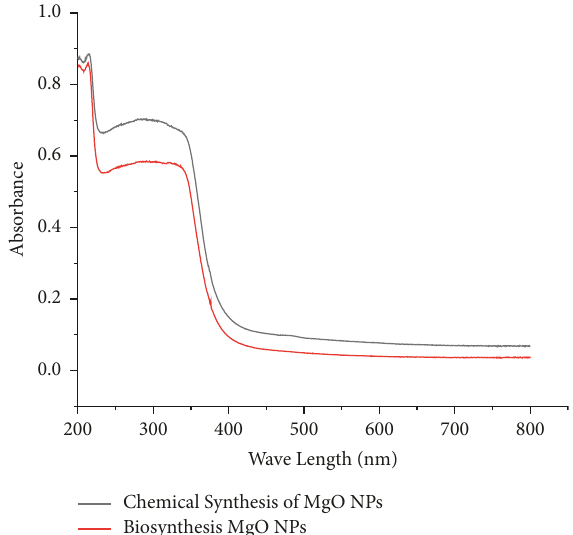
Figure 4: Absorbance measured by UV-Vis of biosynthesized magnesium oxide (MgO) nanoparticles derived from Datura stramonium leaves